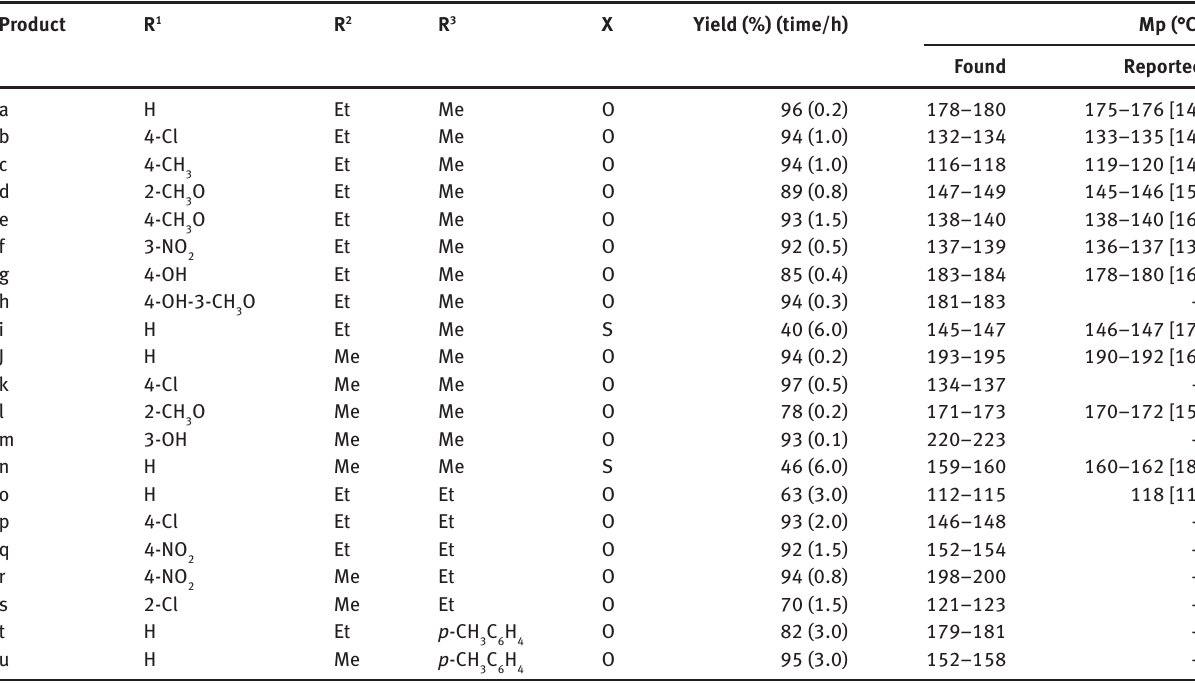
Table 3: Three-component one-pot synthesis of N 1-substituted DHPMs catalyzed by CMS.